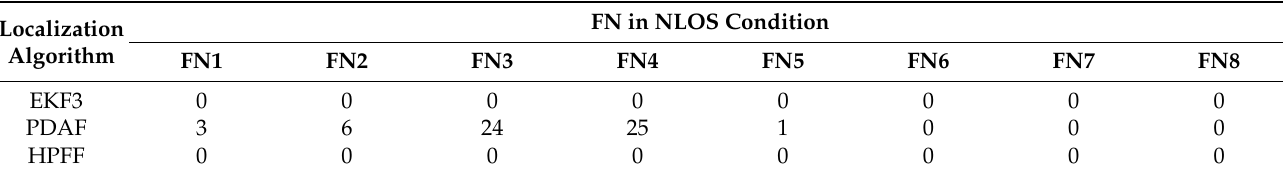
Table 3. Percentage of divergent localizations in constant NLOS